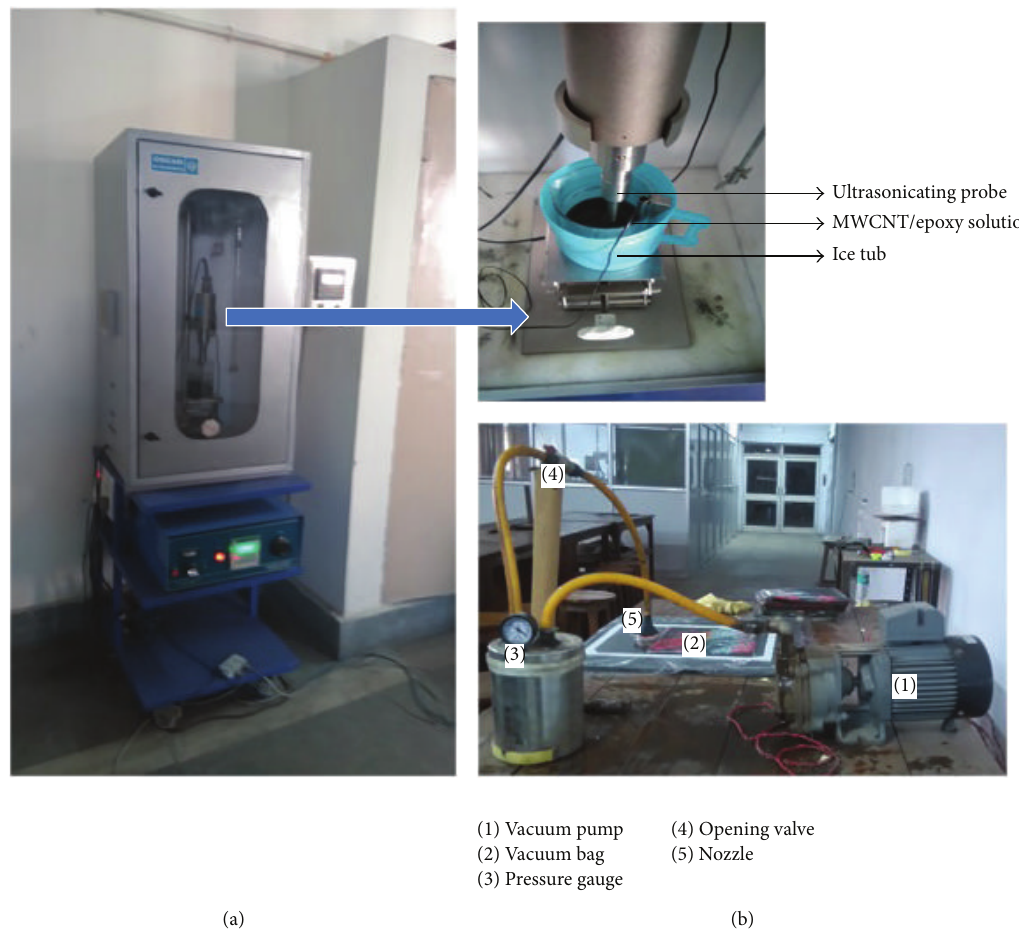
Figure 1: (a) Probe Ultrasonicator (Oscar Ultrasonics Pvt. Ltd. Specification: Power Input 230 V 50 Hz, 4 Amps). (b) Setup of vacuum bagging method used for fabrication of